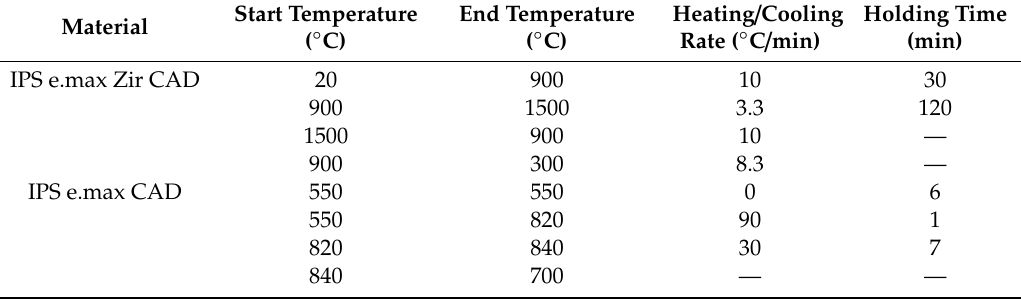
Table 2. Sintering parameters used for IPS e.max ZirCAD (LHT 02 / 16, Nabertherm; Lilienthal, Germany) and IPS e.max CAD (Programat EP5000, Ivoclar Vivadent; Schaan, Liechtenstein) according to the manufacturer’s